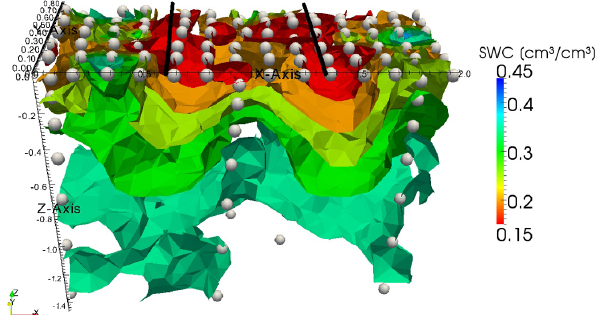
Fig. 10. Three-dimensional volumetric SWC for the ERT ex- perimental plot for the seventh ERT measurement time (31 Au- gust 2009). The surfaces are isosurfaces of equal water content. The isosurfaces represent the volumetric SWC at 0.15 (cm 3 cm − 3 ), 0.2 (cm 3 cm − 3 ), 0.25 (cm 3 cm − 3 ), 0.3 (cm 3 cm − 3 ), 0.35 (cm 3 cm − 3 ). The black lines correspond to the maize row positions and the white spheres represent the electrodes.